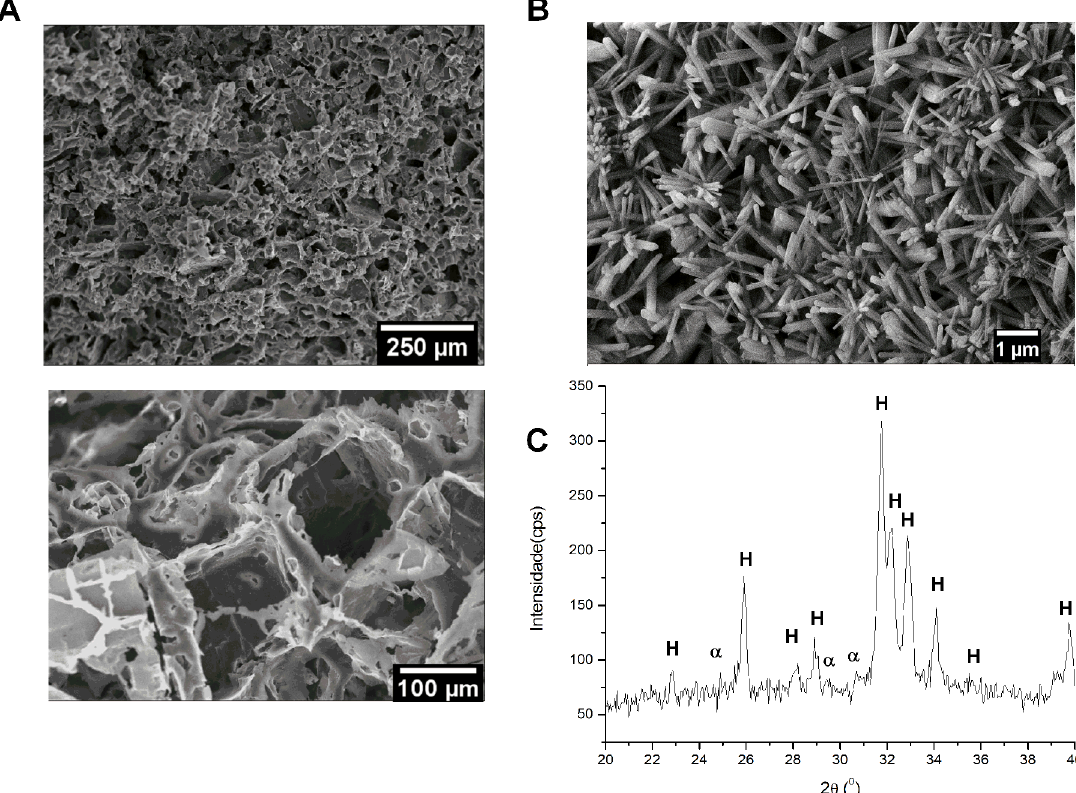
Figure 1. Scaffolds’ characterization, A) SEM images of PCL scaffold (T2/P2), 250 and 100µm scale bar; B) SEM image of CDHA whiskers added on T3 and P3, 1 µm scale bar; C) CDHA XRD diffraction (α and H, indicate α- TCP and CDHA peaks,